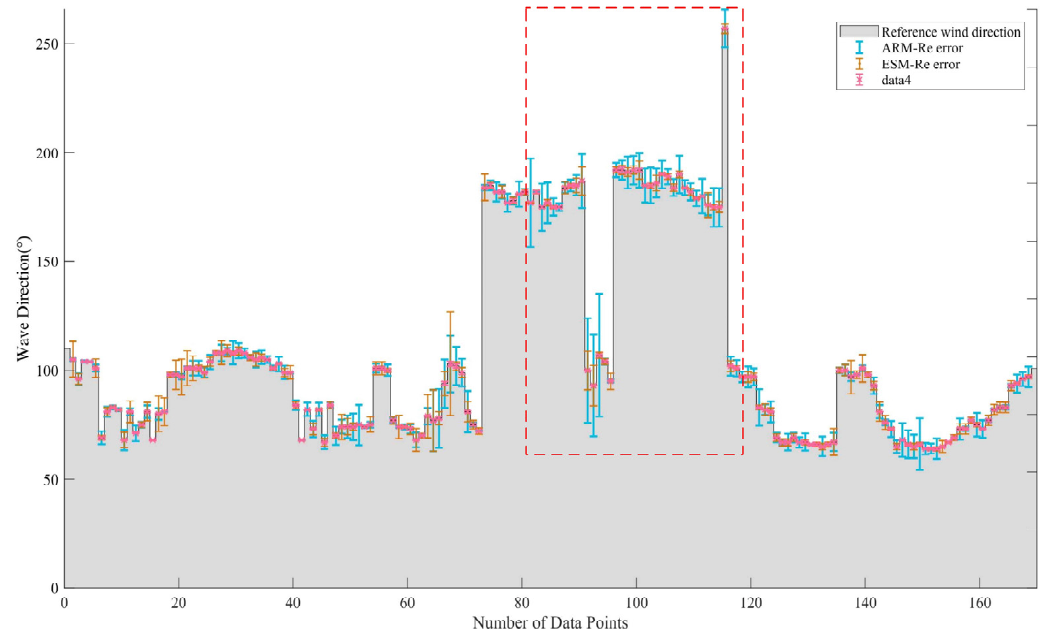
Figure 17. Wind direction error between retrieved direction data and reference wind direction data at different wave directions. (The shaded area represents wave direction data measured by vane and the red dotted box represents the area with large fluctuations in the error